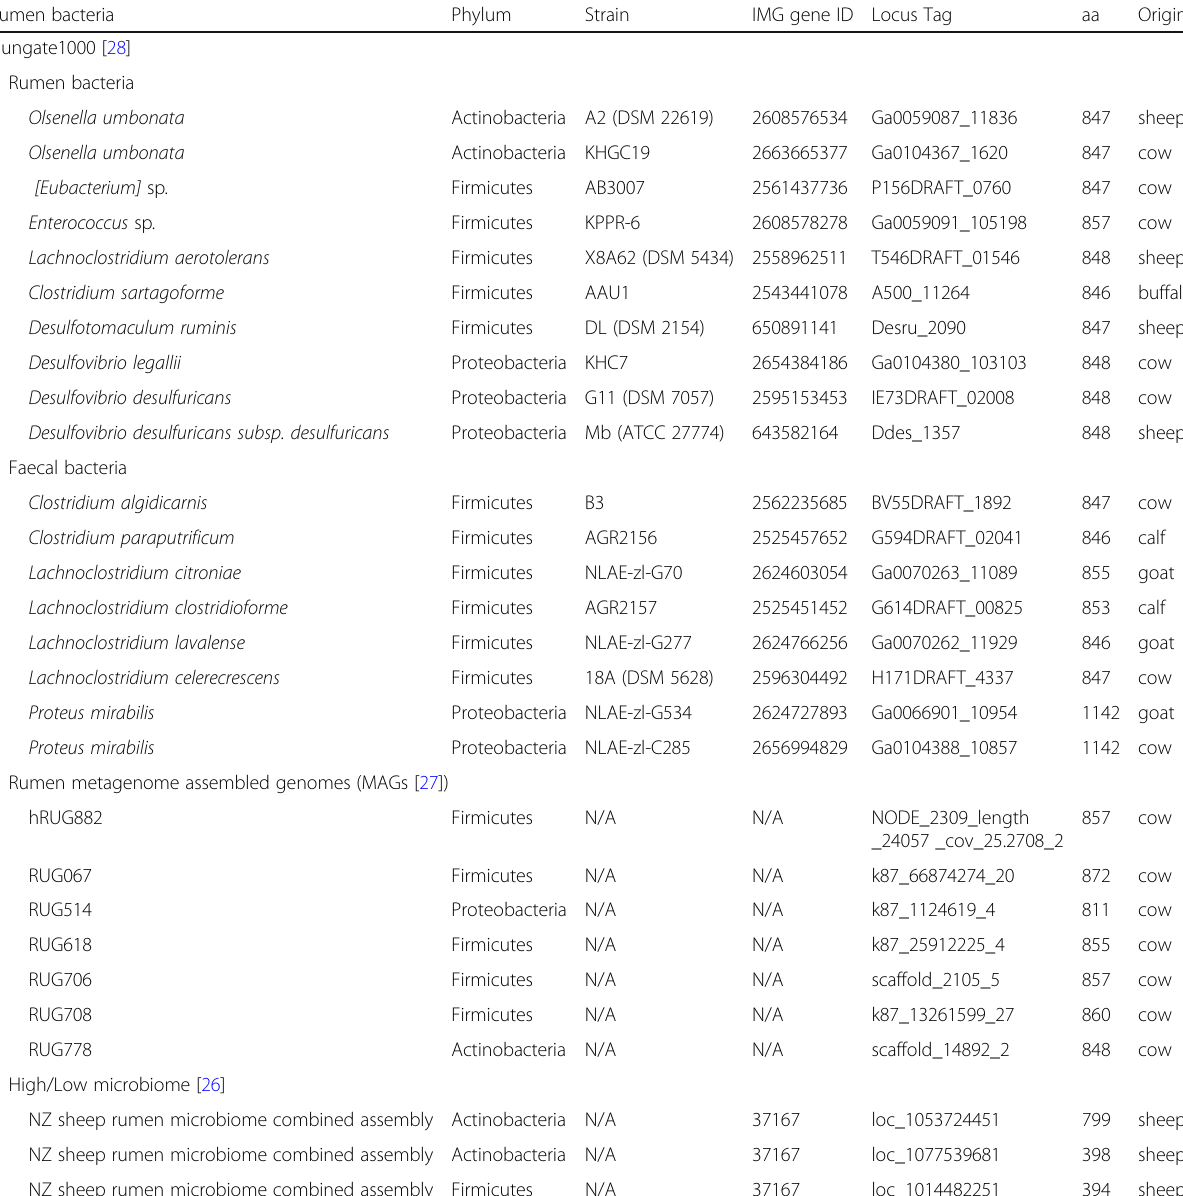
Table 1 Choline TMA lyase gene occurrence in rumen microbial datasets Rumen